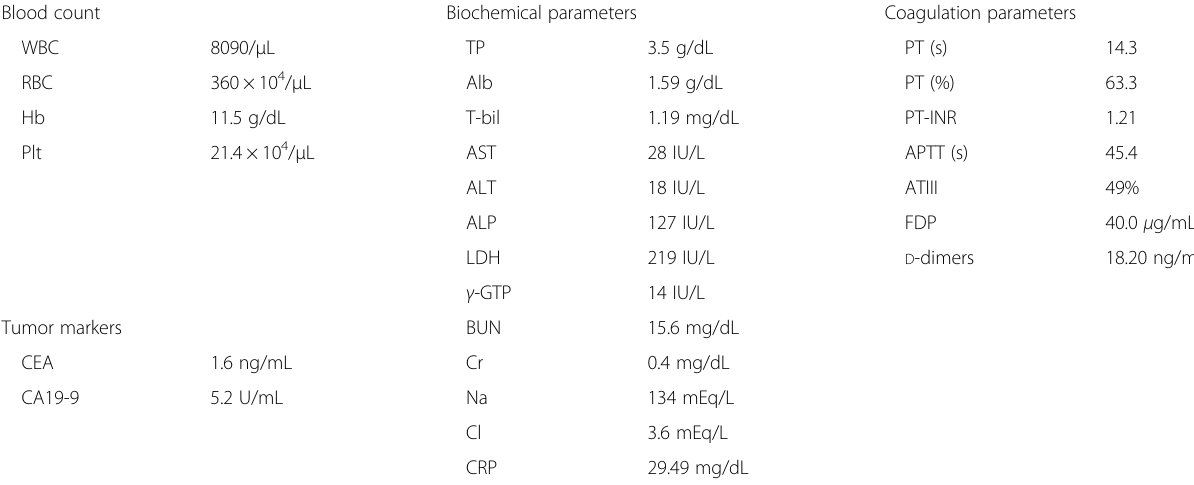
Table 1 Blood examination Blood count Biochemical parameters Coagulation parameters